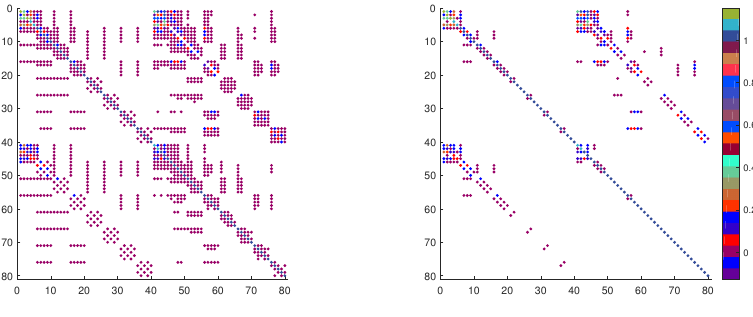
Figure 2. Plot of sparse matrix after thresholding with ε = 10 − 4 ( left ) and ε = 10 − 2 ( right ) for Example 1.